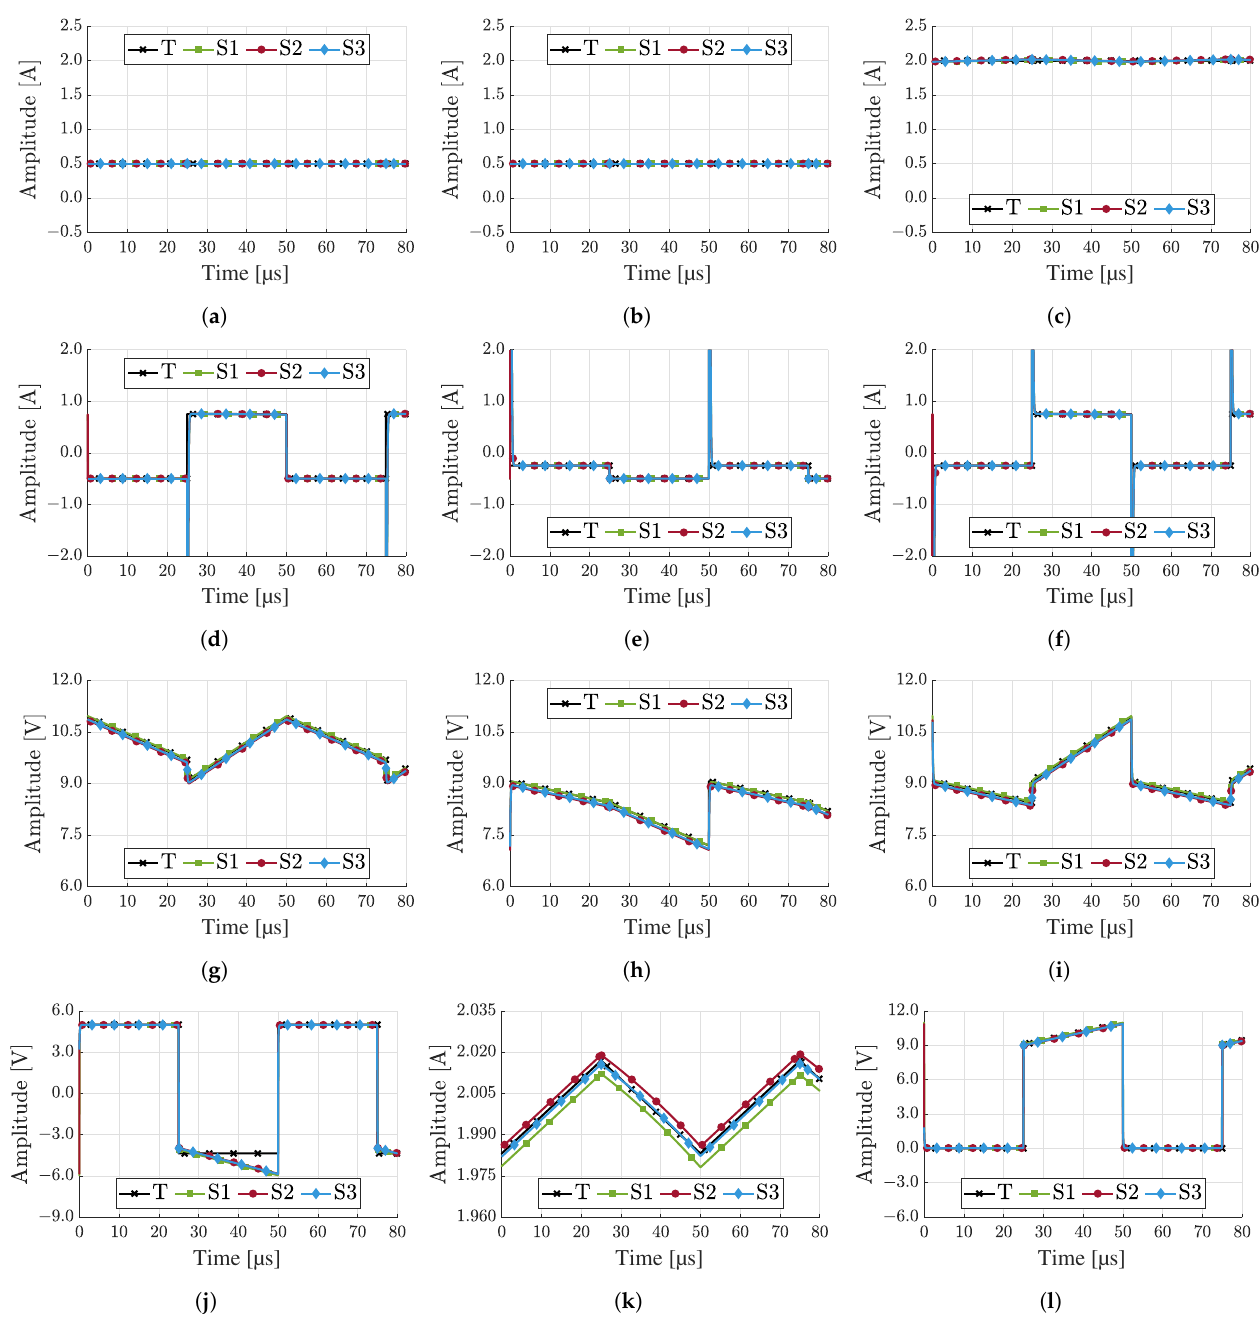
( t ) with small ripple approxima- B ( t ) ; ( k ) i ( t ) without small ripple approximation. L B B